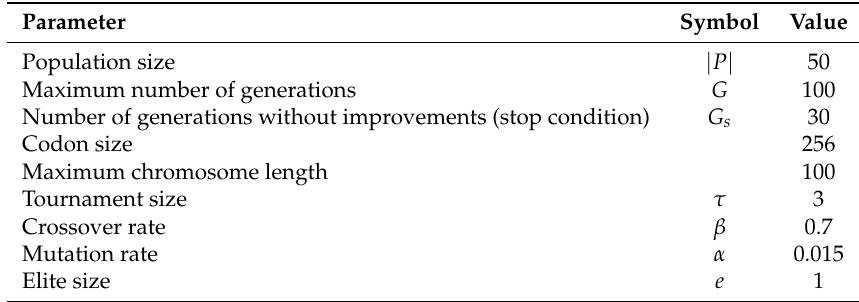
Table 4. List of parameters used in grammatical evolution, with their